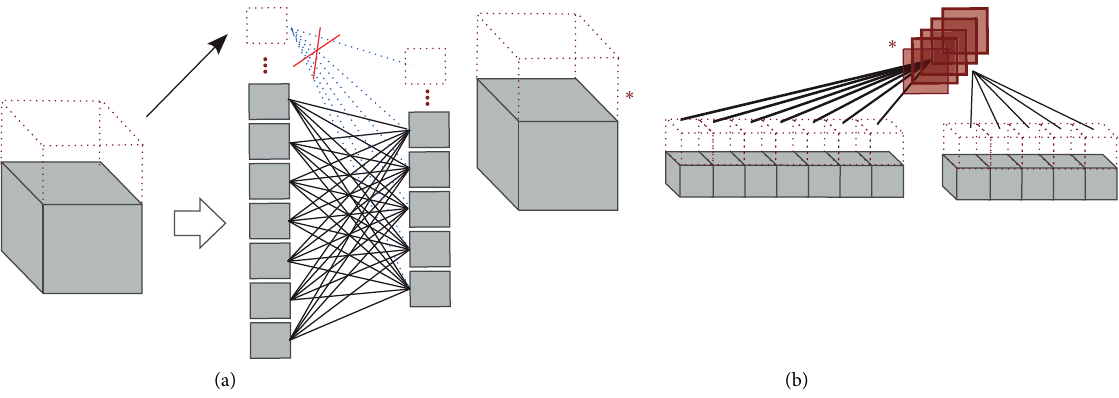
Figure 3: Converting FC layer to 1 × 1 convolutional layer. (a) FC layer. (b) 1 × 1 convolutional layer.